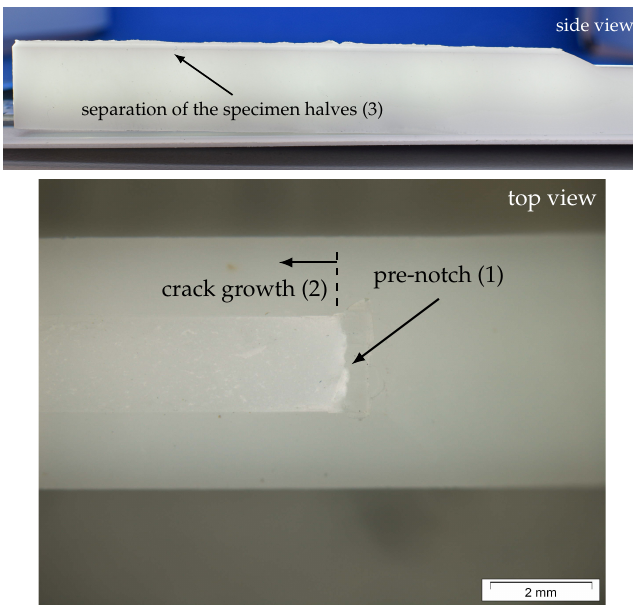
Figure 14. Fracture surface images from a monotonically loaded mode I specimen analyzed using a light microscope (16 magnification)—three areas of different crack areas were observed: pre-notch × before testing (1), the crack growth area (2) and the area produced during the separation of the two specimen halves